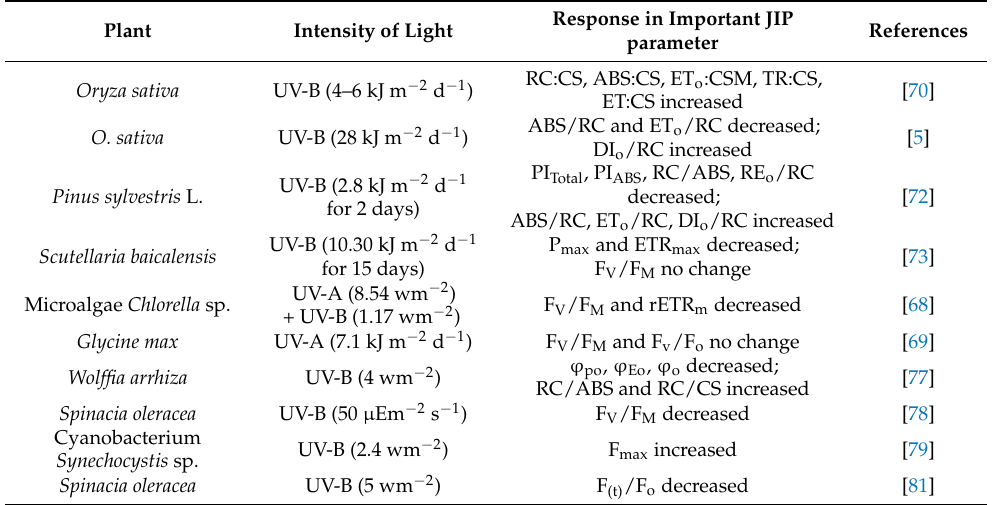
Table 2. Impact of UV radiation on the chlorophyll a fluorescence parameters of different plants.